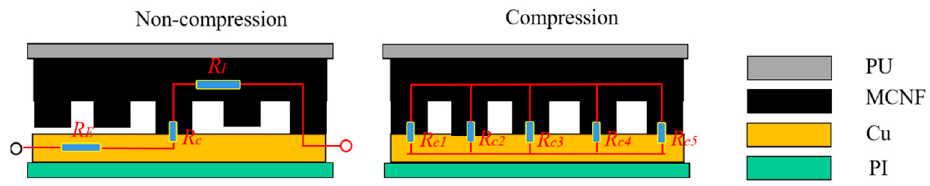
Figure 7. Response mechanism of MCNF pressure sensors.